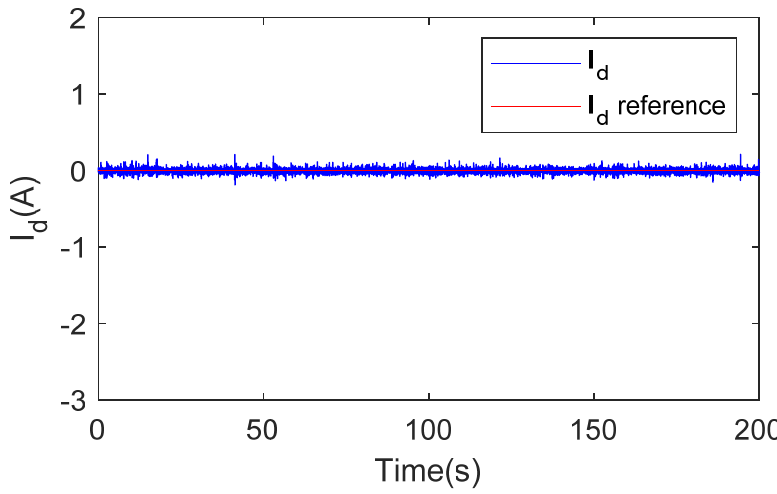
Figure 13. i d current control result with a constant reference.